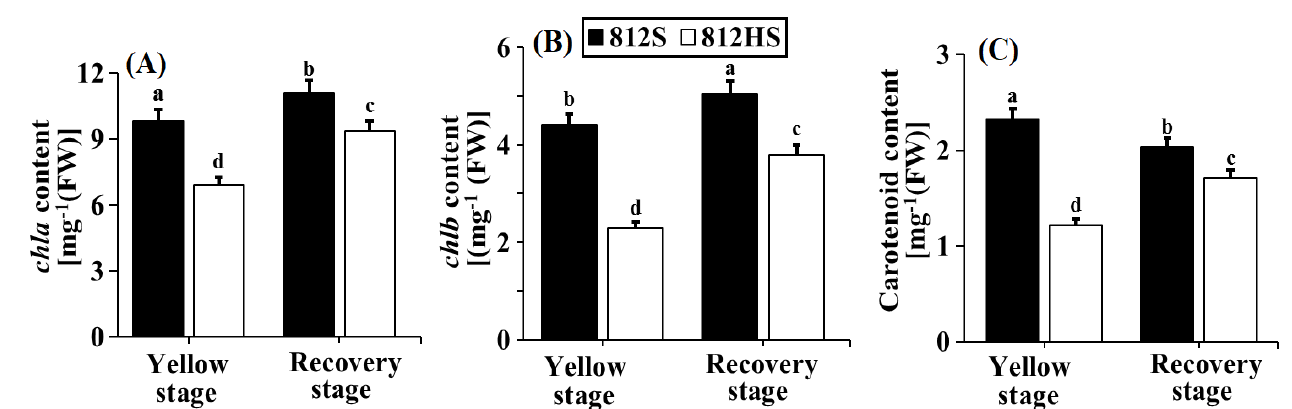
Figure 2. Effect of photooxidation on ( A ) Chl a ( B ) Chl b ( C ) carotenoid content in the rice mutant 812HS. Different letters indicate significant variation ( p < 0.05).